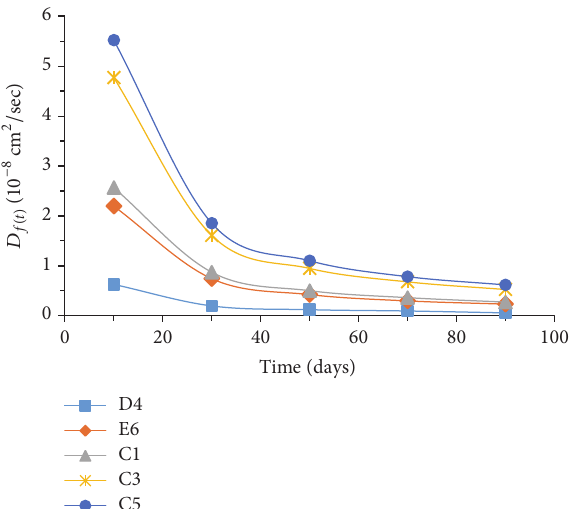
Figure 3: Effect of time on free chloride diffusion coefficient [26].